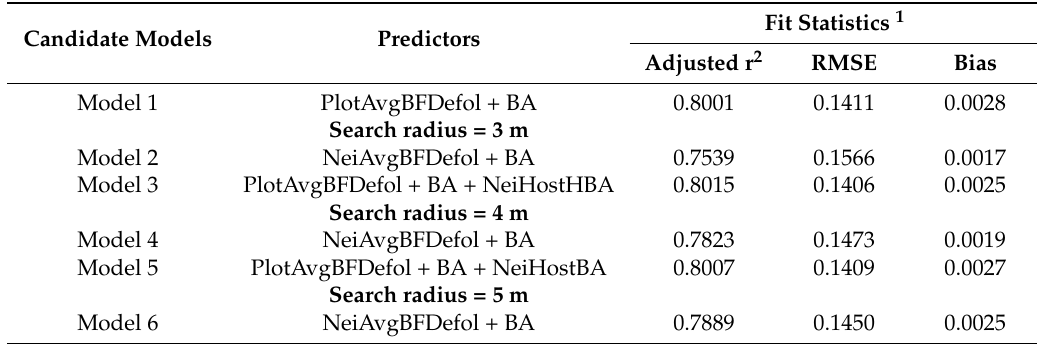
Table 5. Adjusted r 2 , root mean squared error (RMSE), and mean bias of predictions of individual balsam fir defoliation (%) by candidate models with neighborhood tree search radius equal to 3, 4, and 5 m. Predictor variable abbreviations are described in Table